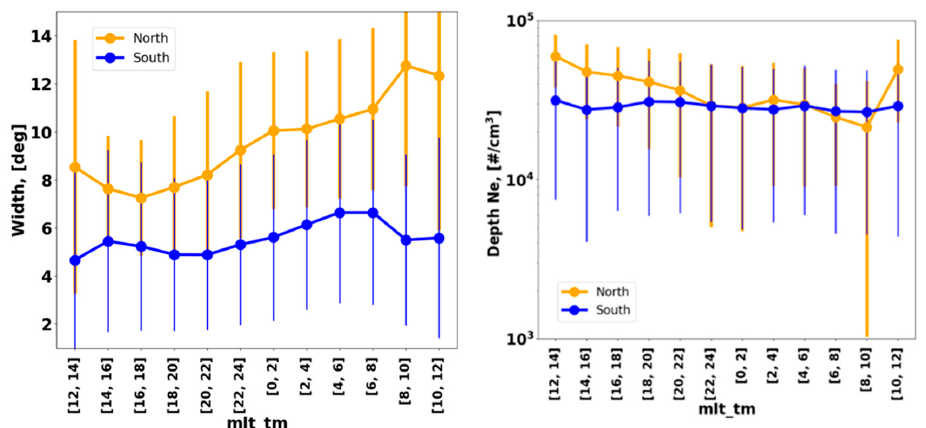
Figure 13. Diurnal variation in trough position for the northern ( a ) and southern ( b ) hemispheres as a function of the magnetic local time. Diurnal variations in the trough width and depth are represented in Figure 14.